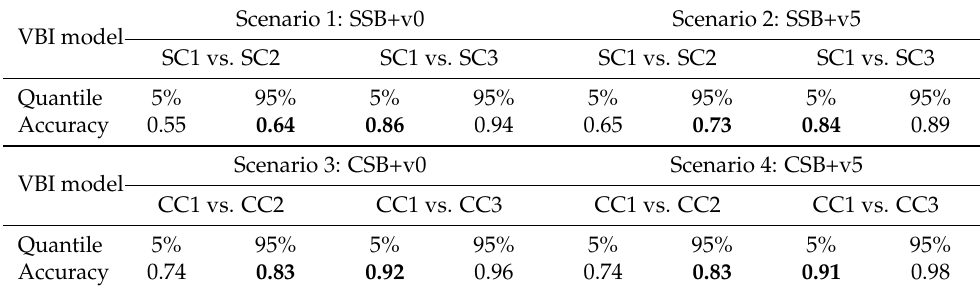
Table 4. Determination of threshold of accuracy values using raw frequency